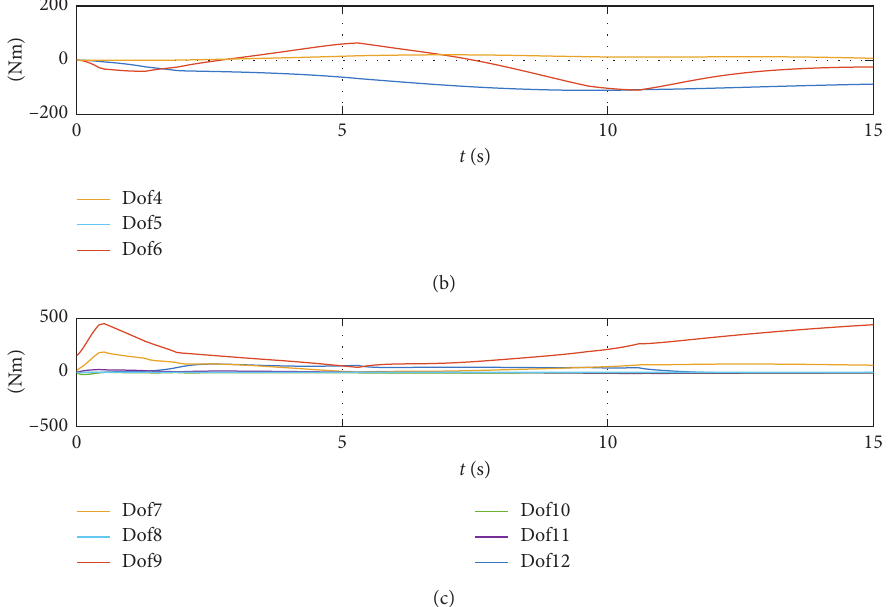
Figure 14: Generalized force variation process of the UVMS driven by the proposed method. (a) Vehicle forces. (b) Vehicle moments. (c) Joint